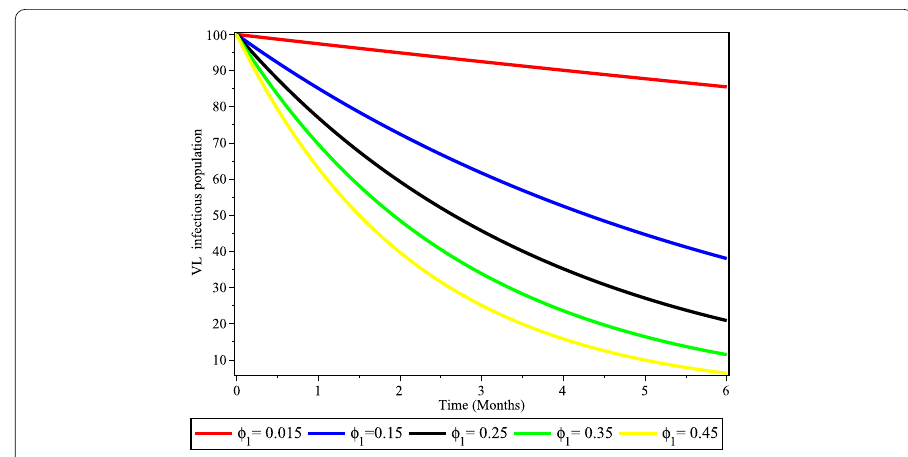
Figure 3 Effect of human recovery rate on VL infectious population